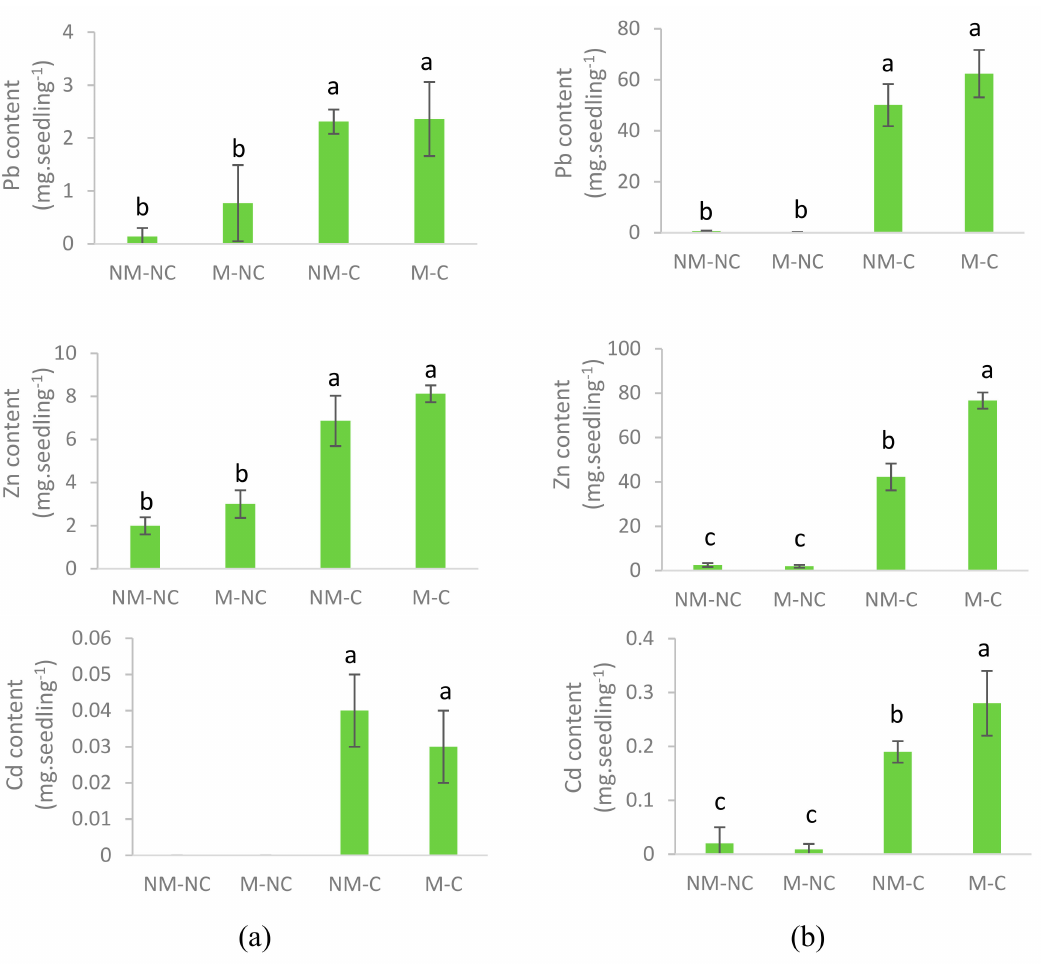
Figure 3. Pb, Zn, and Cd contents in the shoots ( a ) and roots ( b ) of ectomycorrhizal (M) and non-ectomycorrhizal (NM) P. halepensis seedlings after 12 months of exposure to contaminated (C) and control soil (NC). Means ( ± SD, n = 3, composite samples), with di ff erent letters significantly di ff er from each other based on Tukey’s tests at p ≤